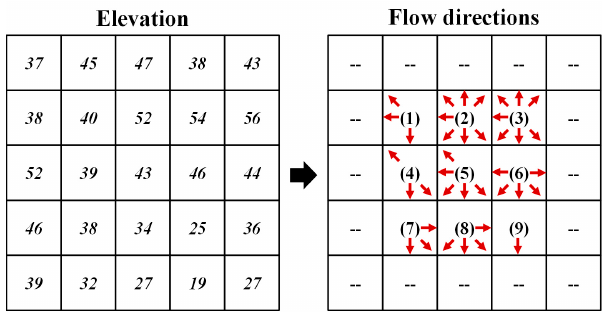
Figure 3. Flow-direction assignation using the MD8 method.